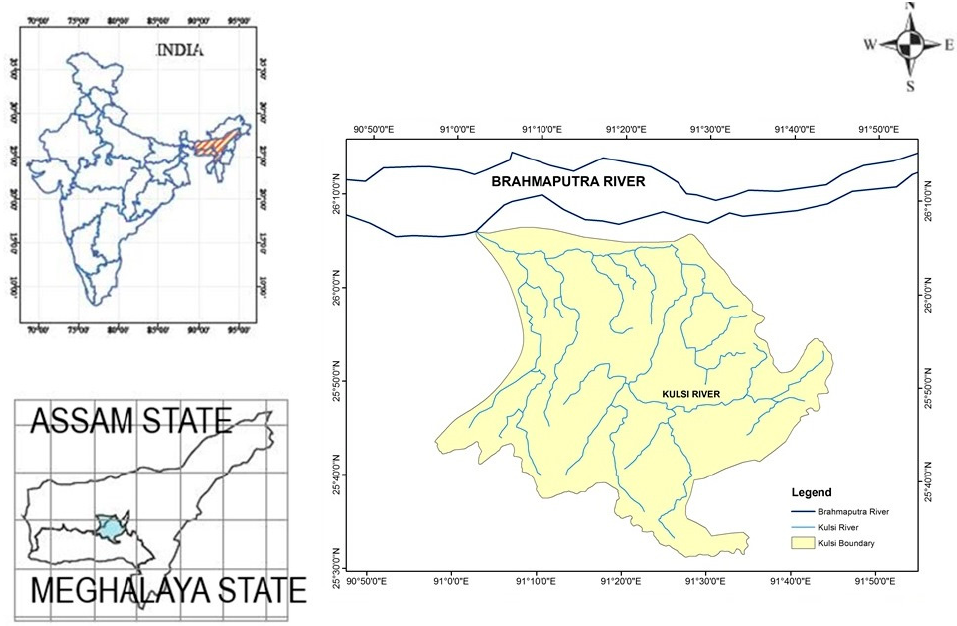
Figure 1. Location of the Kulsi River Basin.